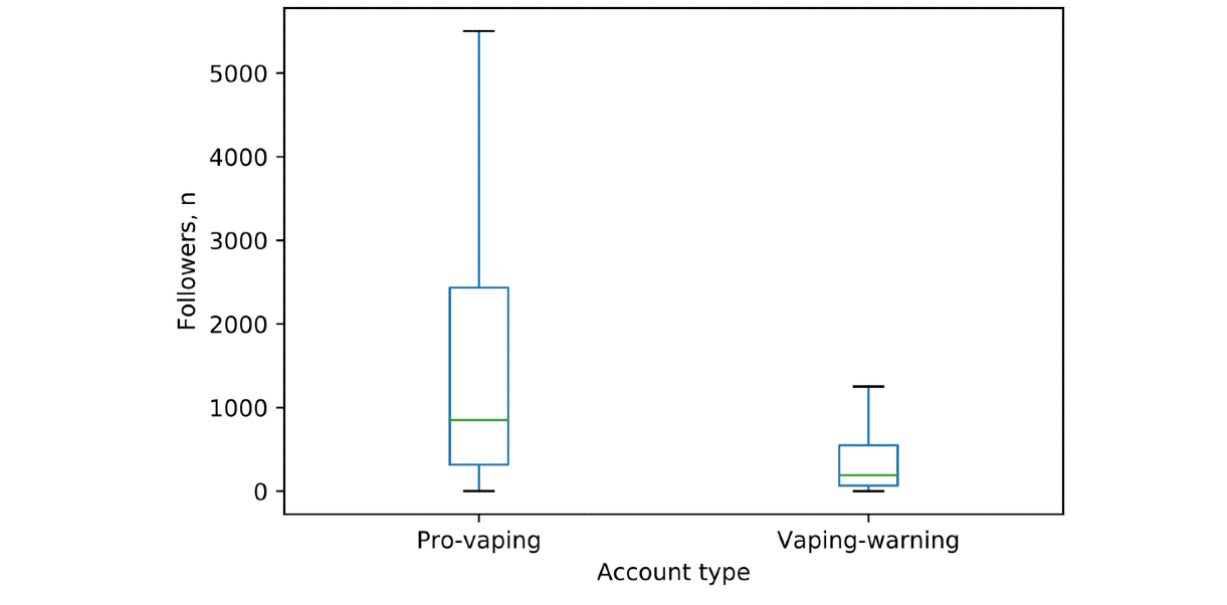
Figure 3. Follower counts of pro-vaping and vaping-warning Instagram accounts.